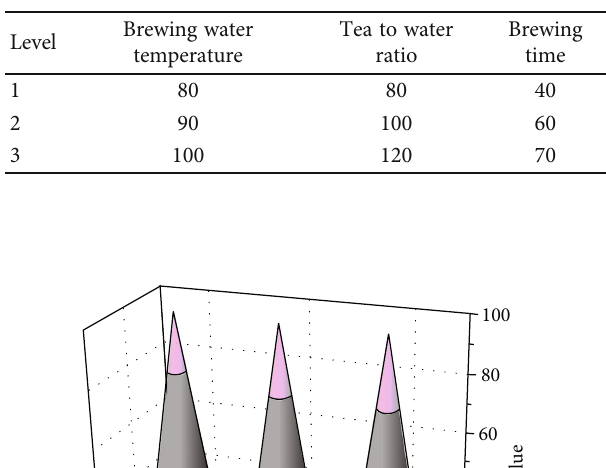
Figure 6: Comparison of tea polysaccharide content and moisture content of the four teas. Table 3: Table of experimental factor levels.